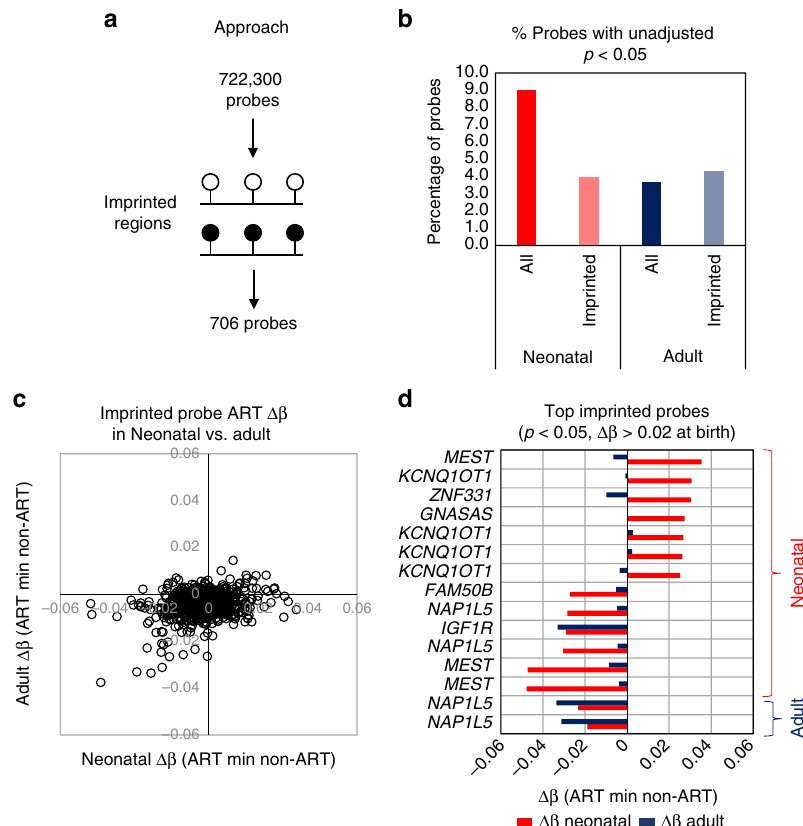
Fig. 5 No evidence for ART-associated DNA methylation change at imprinted genes. a Strategy for analysis of DNA methylation at imprinted gene regions. A total of 706 probes mapped within 50 imprinted regions. b Column plot showing the percentage of all probes and probes at imprinted regions showing a difference between ART and non-ART groups at an unadjusted p -value <0.05 (Bayesian levene ’ s test). This analysis shows that imprinted regions are less likely to have an ART-associated DNA methylation change than the average gene region. c Correlation plot of mean DNA methylation change between ART and non-ART in neonatal ( x -axis) and adult ( y -axis) blood at all imprinted probes. This shows that no probes show a Δβ ≥ 4% in adults, while only two probes meets this criteria in neonatal blood. d Bar plot of neonatal (red) and adult (blue) blood Δβ values for top ranked imprinted probes based on methylation change in neonatal or adult blood, with name of nearest